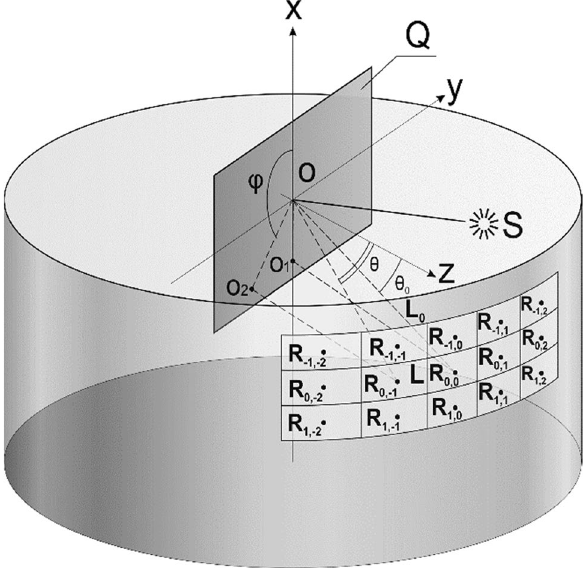
Figure 2. Schematic diagram of the formation of 3D images by a flat optical phase element.